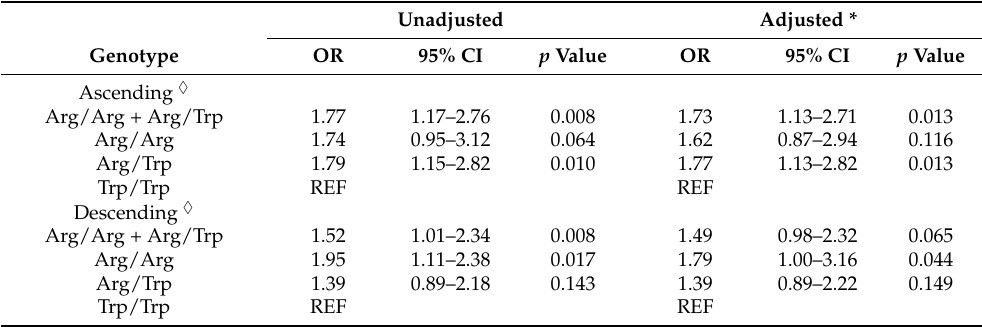
Table A2. Association of KIF6 719Arg with ascending and descending thoracic aortic dissection (typical and intramural hematoma cases).